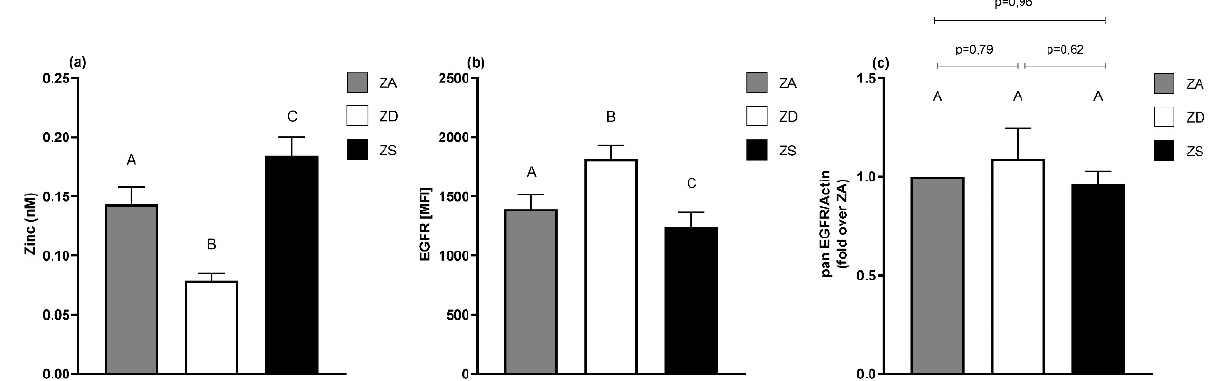
Figure 1. EGFR surface expression depends on cellular zinc content. A549 cells were cultured in zinc-adequate (ZA), zinc-deficient (ZD) or zinc-supplemented (ZS) medium for four days. Intracellular free zinc concentrations were analyzed using Zinpyr-1 via flow cytometry ( a ). Intracellular zinc contents are affected according to medium zinc content. Data for n = 6–10 independent experiments are shown as means + SEM. The EGFR surface expression of ZA, ZD and ZS cells was measured using flow cytometry ( b ). Zinc deficiency leads to an increased EGFR surface expression while zinc supplementation decreases the EGFR surface expression in A549 cells. Mean fluorescence intensities (MFI) of n = 11 independent experiments are presented as means + SEM. Total amounts of EGFR in ZA, ZD and ZS A549 cells were detected by Western blotting and normalized over β -actin ( c ). Data for n = 9 independent experiments are shown as means + SEM. Statistical significances between data sets were calculated using one-way ANOVA and Tukey’s post hoc test ( p < 0.05). The same letter is never shared by statistically different data sets.